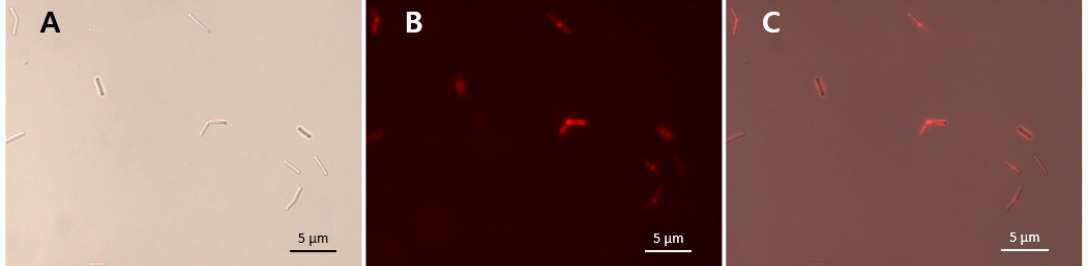
Figure 5. mCherry_LysCPS2_CBD binding activity. LysCPS2_CBD binds to C. perfringens human isolate cells. Bright field ( A ), fluorescence ( B ) and merged ( C ) images are shown.